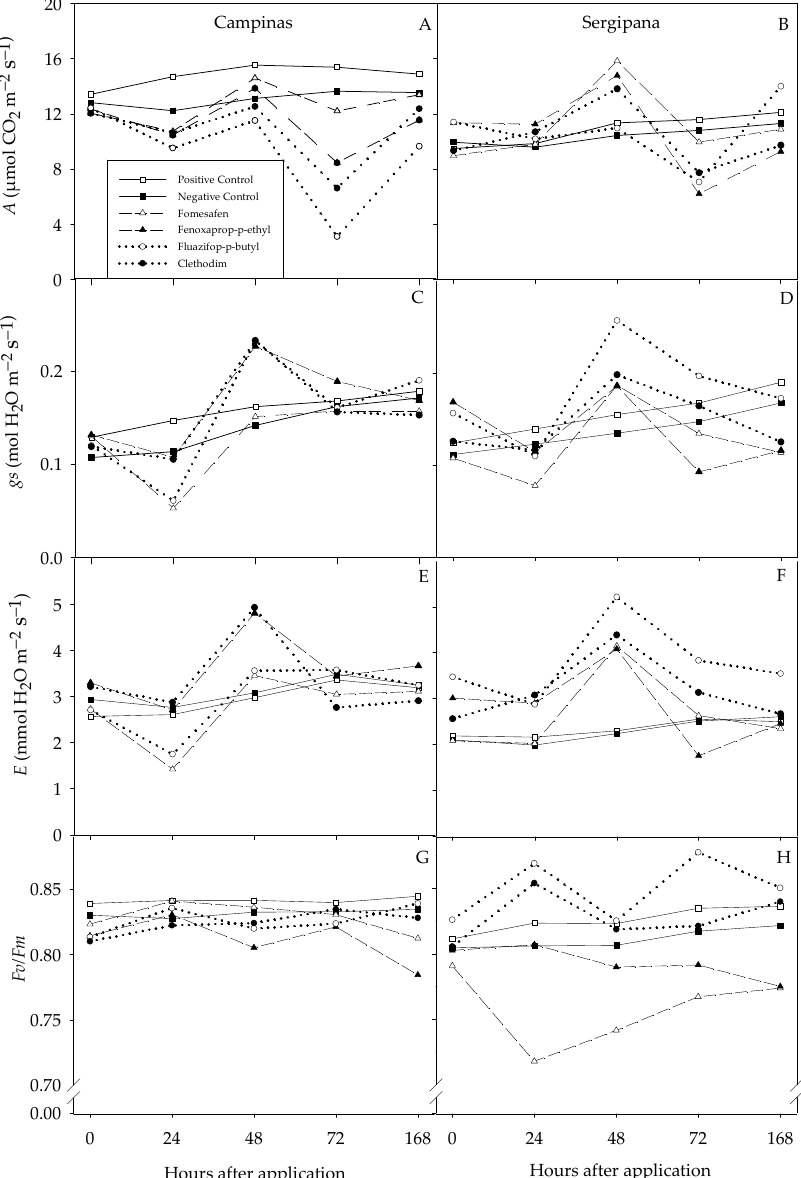
Figure 1. Net photosynthetic rate − A ( A , B ), stomatal conductance − gs ( C , D ), transpiration rate − E ( E , F ), and maximal quantum yield of PSII photochemistry − Fv/Fm ( G , H ) of two M. esculenta Crantz cultivars (Campinas and Sergipana) after application of chemical molecules. The data represent average values ± standard error.